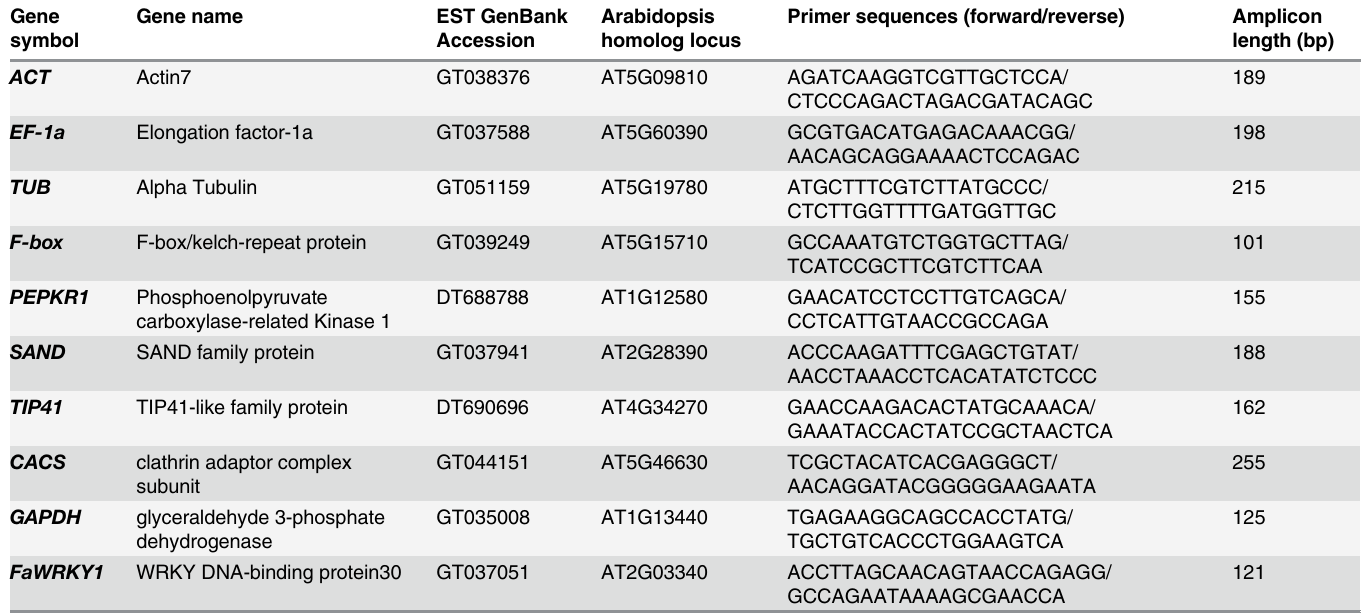
Table 1. Candidate reference genes and primer